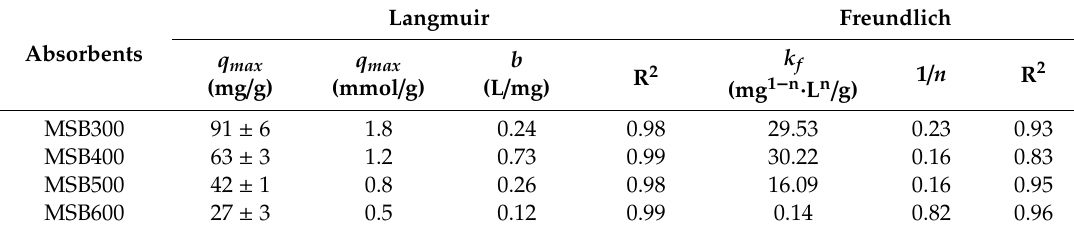
Table 2. The parameters of the Langmuir and Freundlich models of Cr(VI) adsorption.